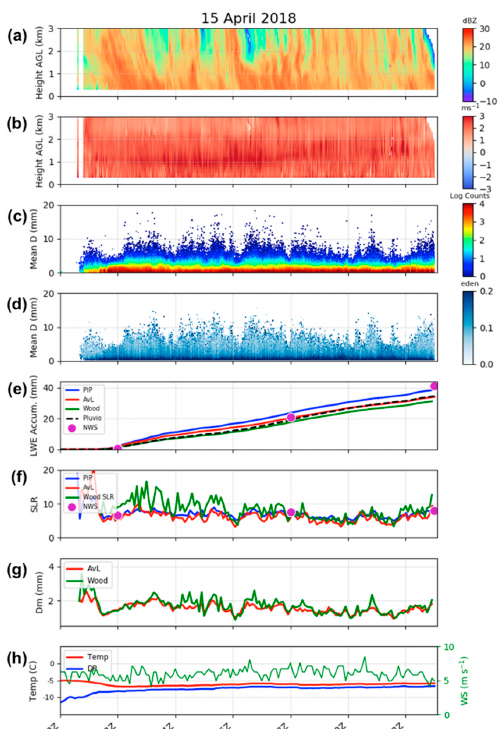
Figure A1. Example of a low SLR snow event on 15 April 2018. ( a ) Shown is data from the MRR reflectivity, ( b ) MRR Doppler velocity, ( c ) PIP-produced PSDs, ( d ) PIP-derived ρ e distribution as a function of D e , ( e ) LWE accumulation for all three retrievals, the Pluvio, and the NWS 6-hourly snow field, ( f ) calculated SLR from all three retrievals and the NWS 6-hourly snow field observations, ( g ) the mass-weighted diameter ( D m ) from von Lerber and Wood, ( h ) and the surface meteorological conditions . All variables are presented as a function of time from 1000 UTC to 2300 UTC.